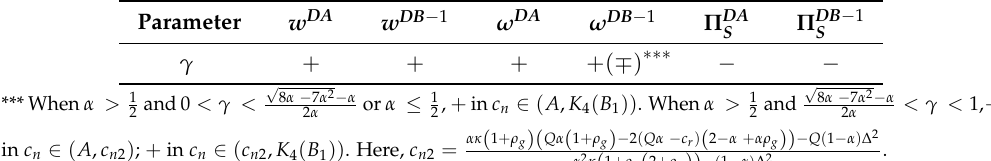
Table 9. The impact of mandated remanufacturing target on the supplier’s decisions.